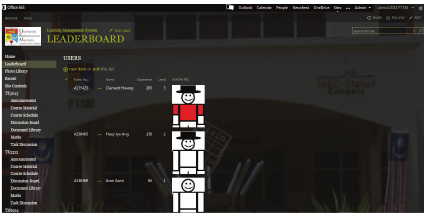
Figure 2: Screenshot of the leaderboard.